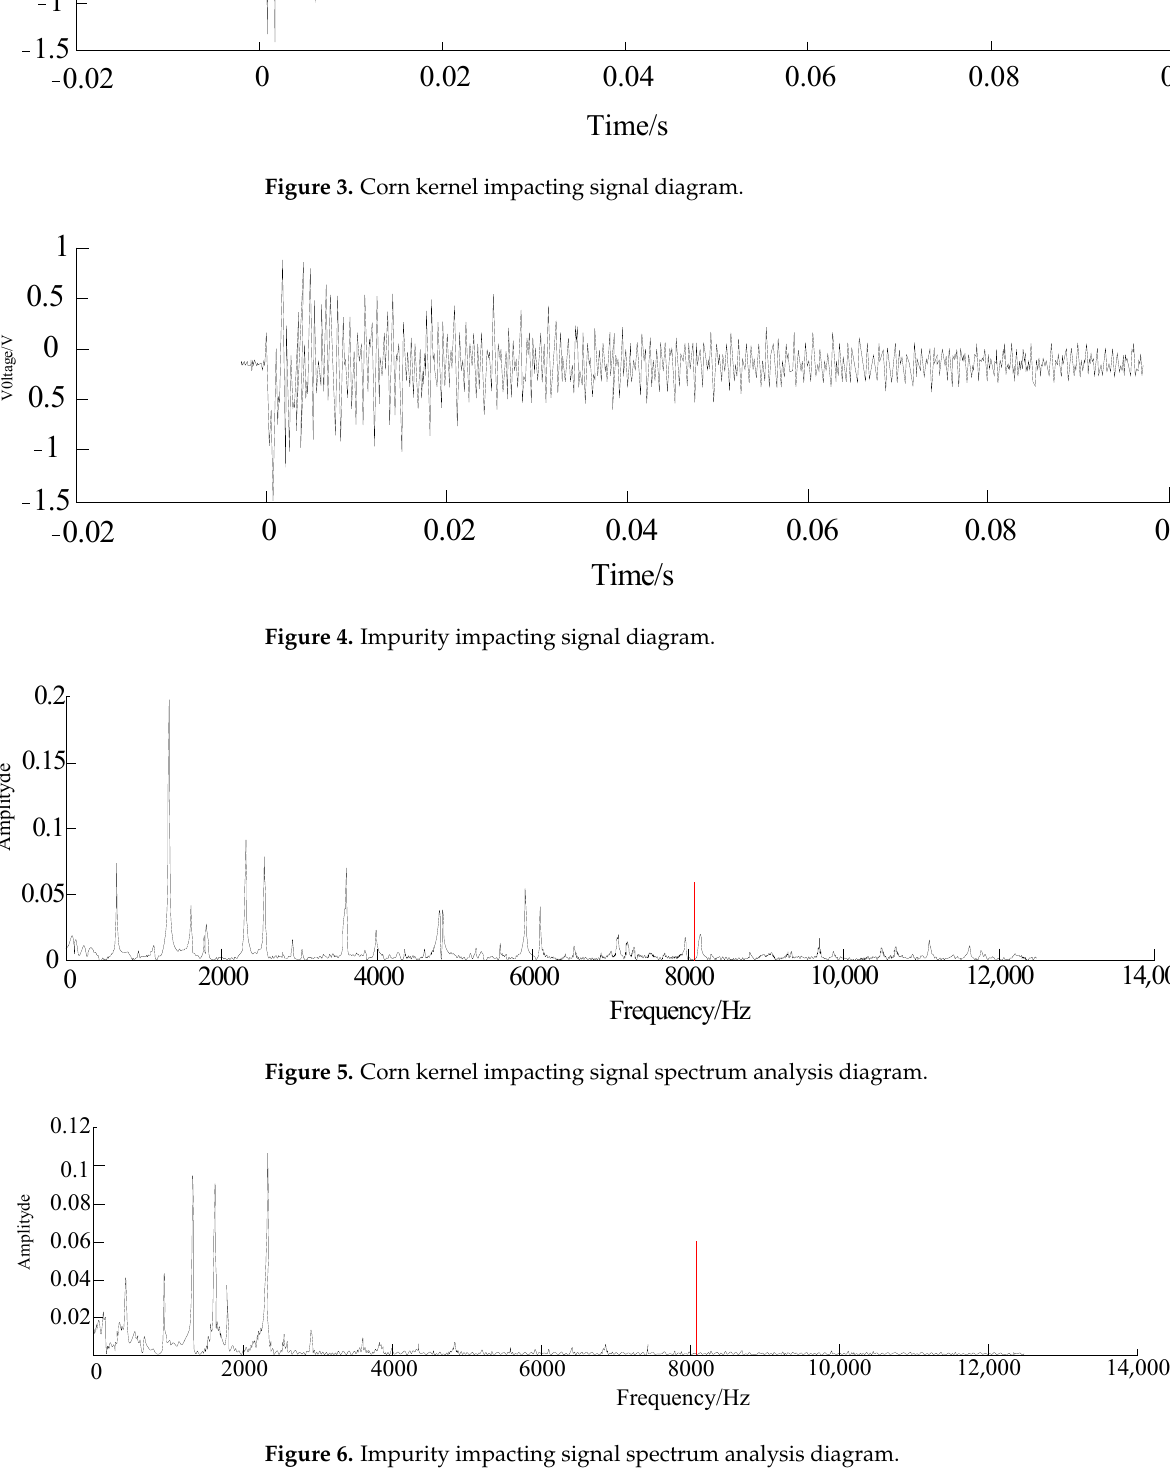
Figure 6. Impurity impacting signal spectrum analysis diagram.